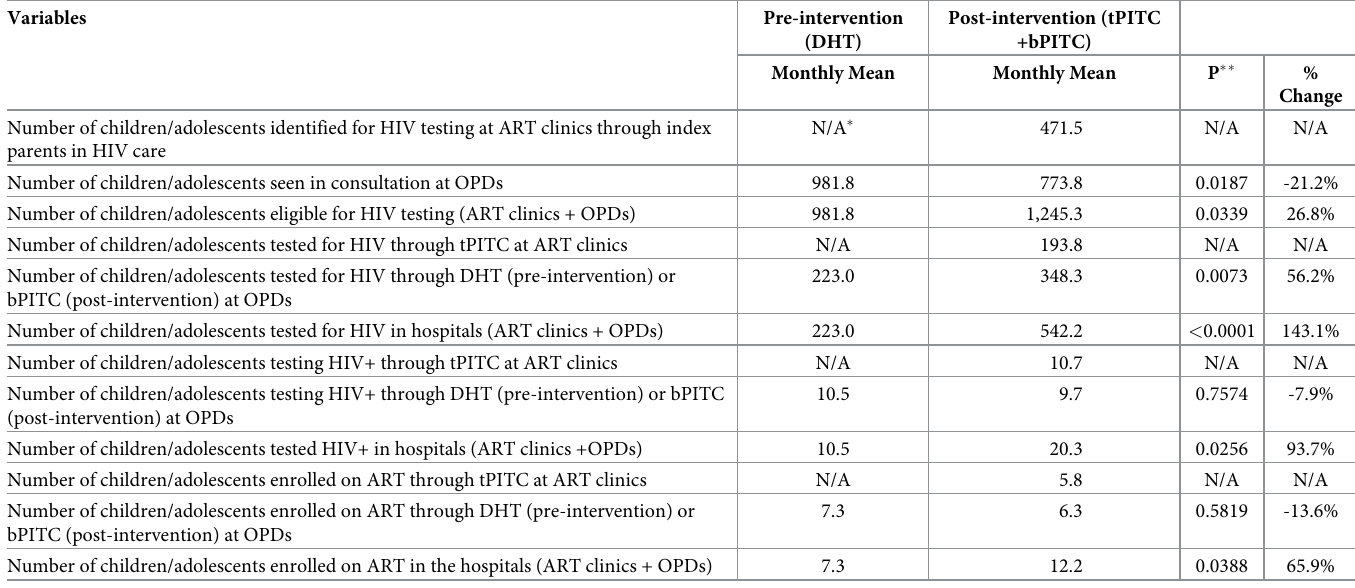
Table 1. Outcomes of 6-month implementation of DHT versus bPITC+tPITC among children/adolescents at three hospitals in Cameroon.